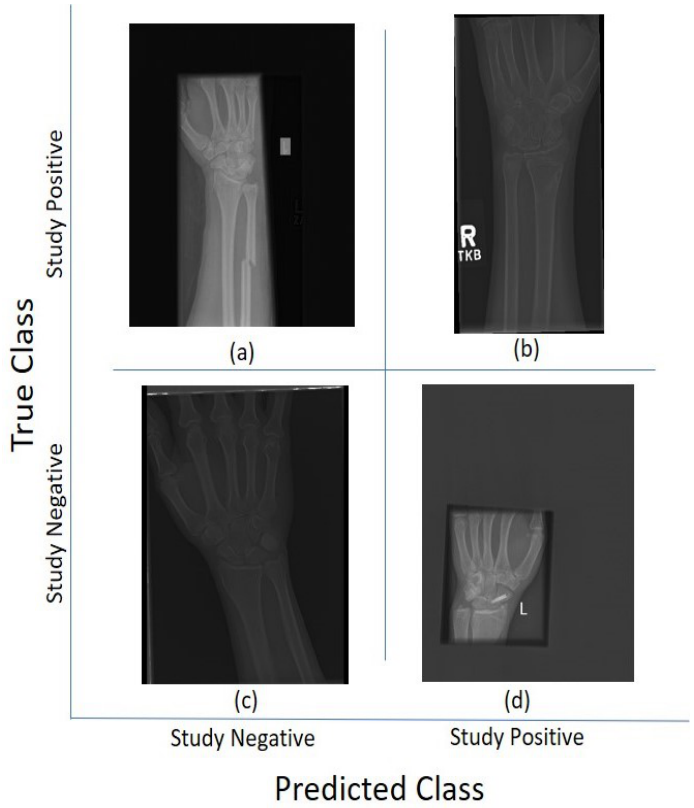
Figure 6. Illustration of classification results for postero-anterior (PA) views of wrist radiographs. ( a ) corresponds to a positive (abnormal) diagnosis image that is predicted as negative (normal); ( b ) to abnormal diagnosis and abnormal prediction; ( c ) to normal diagnosis image and normal prediction; and ( d ) to normal diagnosis and abnormal prediction. Notice again that the errors in classification may have been biased by artefactual elements on the